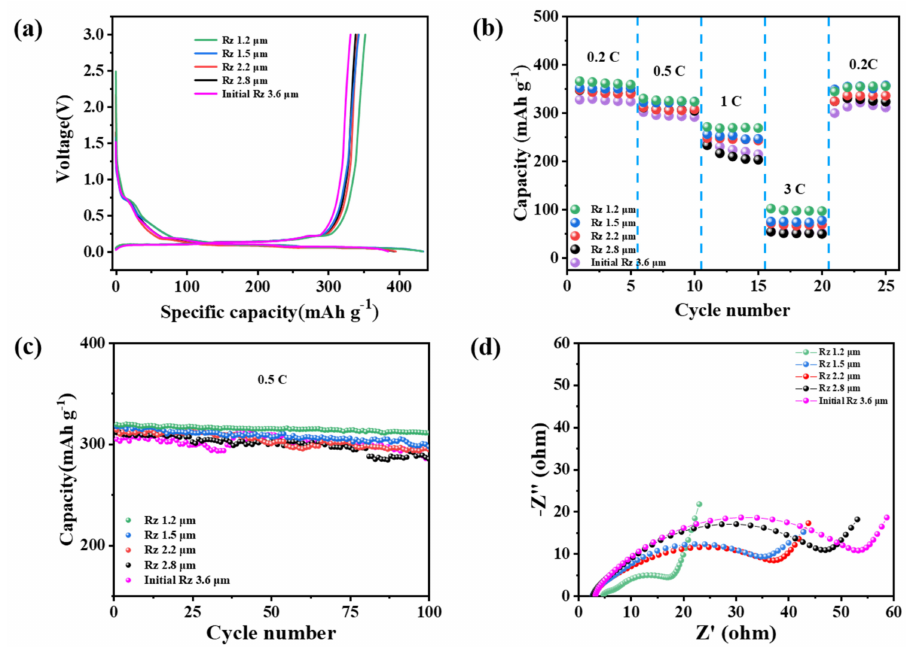
Figure 5. Electrochemical performance of CF@graphite electrodes with different roughness: ( a ) Initial charge/discharge curves ( b ) Rate performance. ( c ) Cycle performance on 0.5 C from 0.01 to 3 V. ( d )